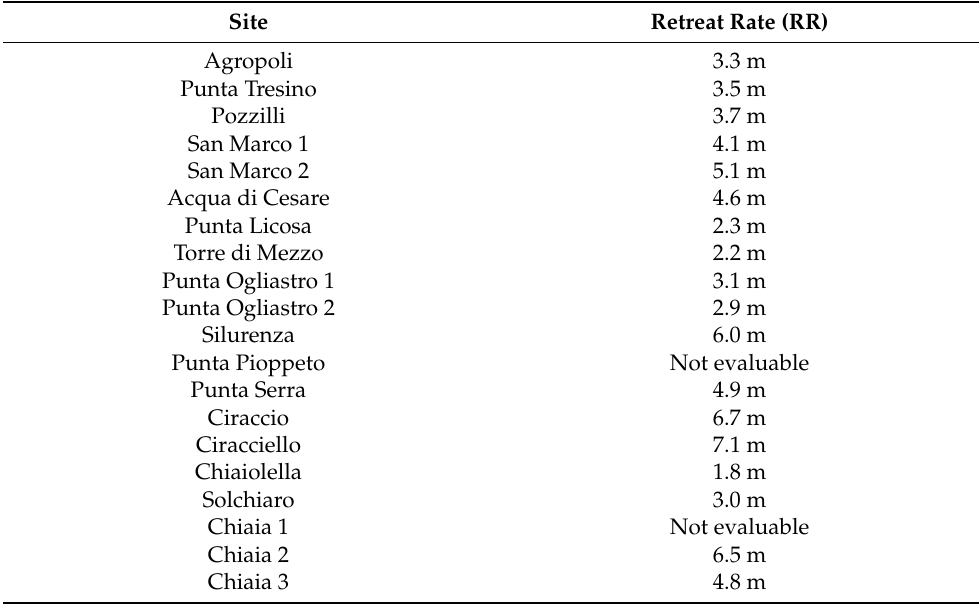
Table A1. Values of the Cliff Retreat Rate (RR) from 1989 to 2021 of analyzed high coastal